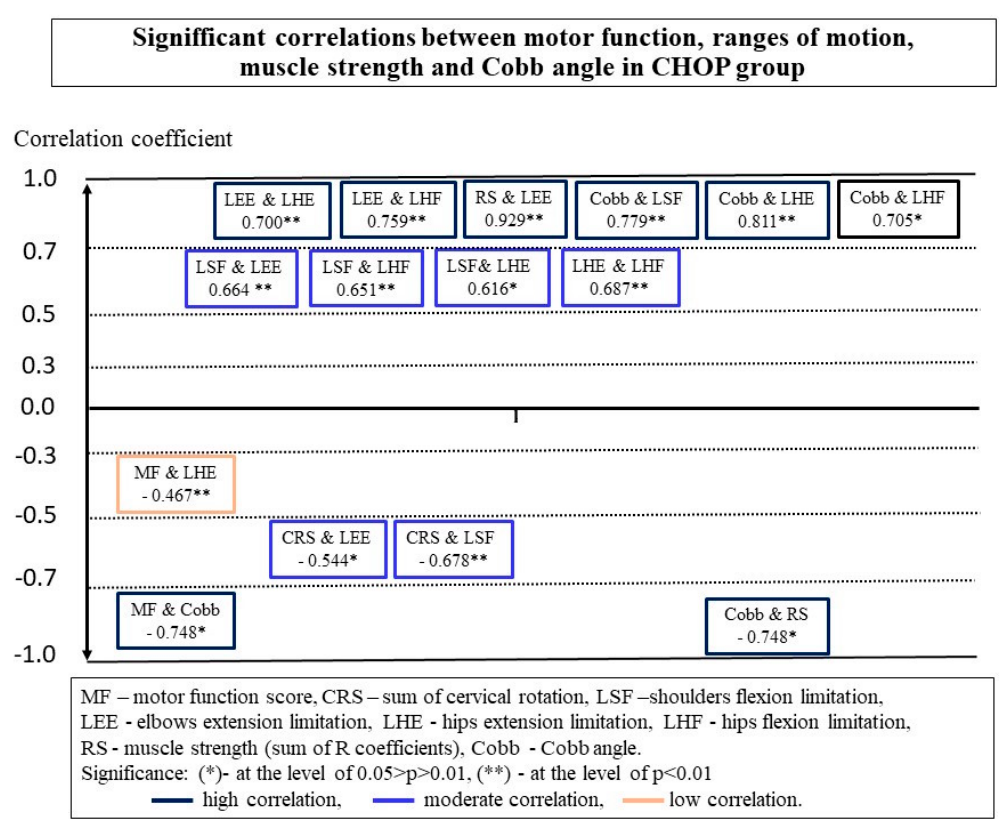
Figure 2. Significant correlations between motor function, range of motion, muscle strength, and Cobb angle in the CHOP group.